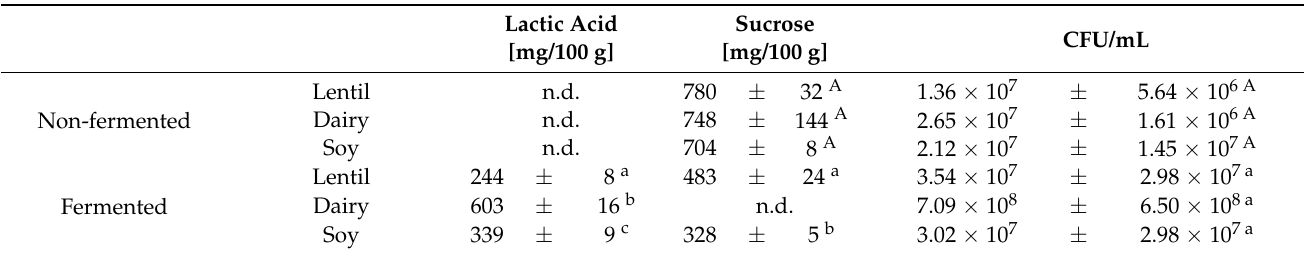
Table 1. Lactic acid content, sucrose content as measured by HPLC, and microbial cell count displayed as colony forming units (CFU) in non-fermented and fermented samples and controls. N.d.: not detected or below 0.6 mg/100 g for lactic acid and below 0.5 mg/100 g for sucrose. Values are displayed as means plus minus standard deviation. Values within the non-fermented and fermented groups with different superscript letters (capital letters for non-fermented, lowercase letters for the fermented group) are significantly different ( p ≤